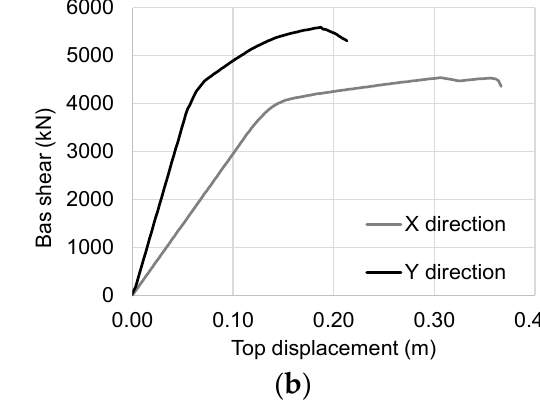
Figure 12. Capacity curves for the fixed base model ( a ) SSI model for X and Y directions ( b ). The target displacement, also called the seismic demand displacement (d D ), which represents the displacement of the top floor in a seismic event, was determined by using the N2 method. Two levels of the peak ground acceleration (PGA) were considered, namely PGA = 0.215 g, for a return period of 475 years and PGA = 0.10 g, for a return period of 95 years.